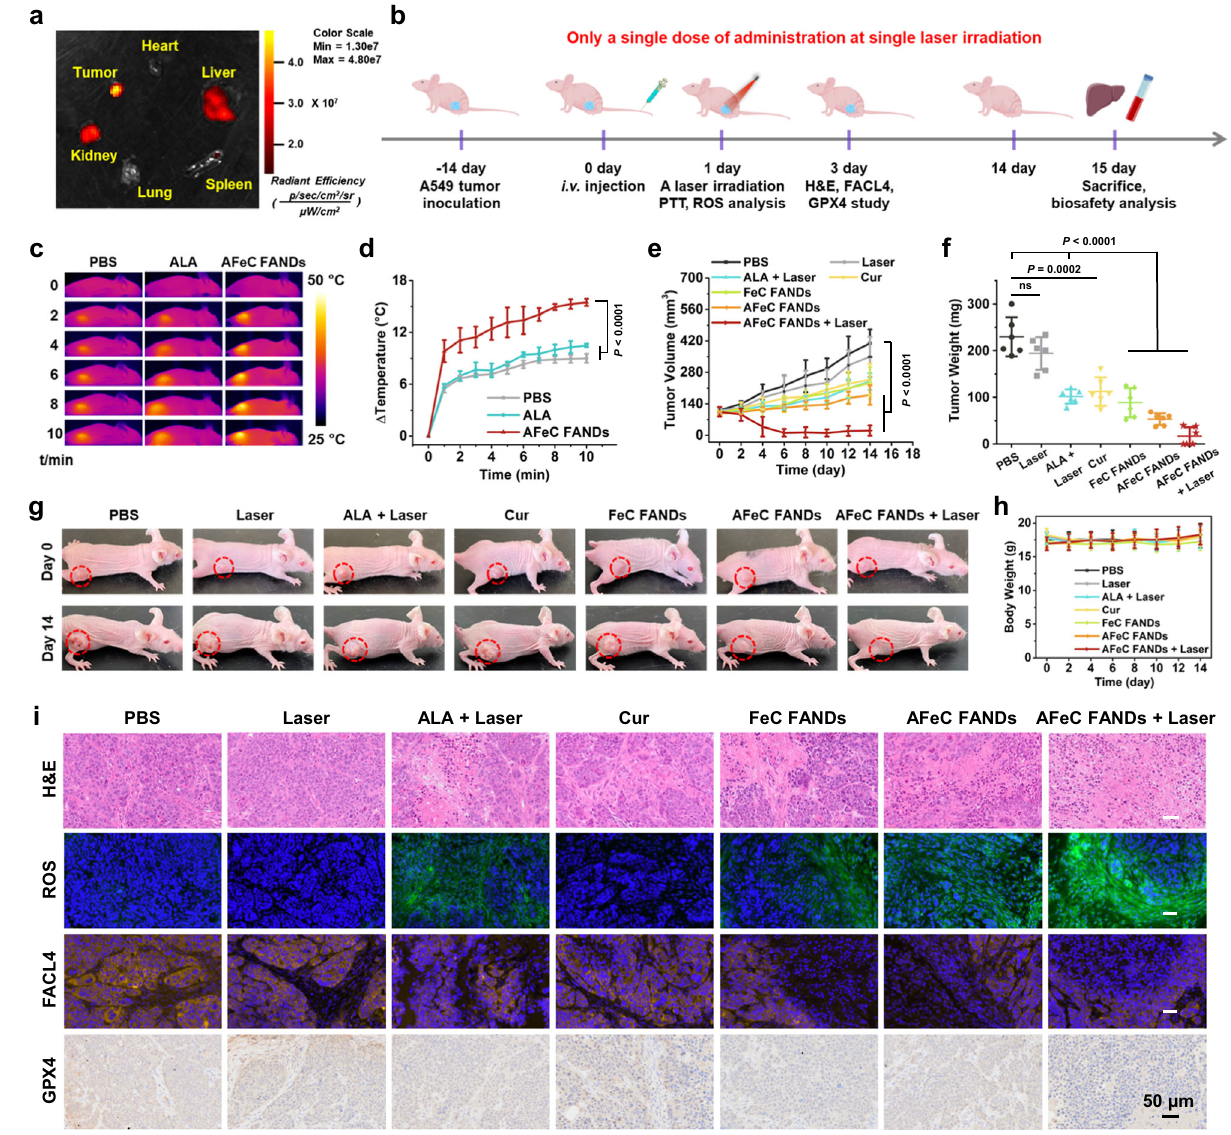
Fig. 6 | In vivo antitumor activities of the AFeC FANDs. a Ex vivo fl uorescence imaging of the tumor and major organs from mice after i.v. injection of the AFeC FANDs. b Treatment schedule for the anticancer ef fi ciency and mechanism assessments of the as-prepared FANDs. c Infrared thermal images of the mice and d the corresponding temperature rises of tumors after treatment with PBS, 5-aminolevulinic acid (ALA), AFeC FANDs upon 635nm laser at different time intervals. e Tumor volumes of mice with various treatments during 14 days. f Weightsofthetumorsextractedfrommiceinvariedgroupsattheendoftherapy. g Photographs of A549tumor-bearing micein different groups before and after 14